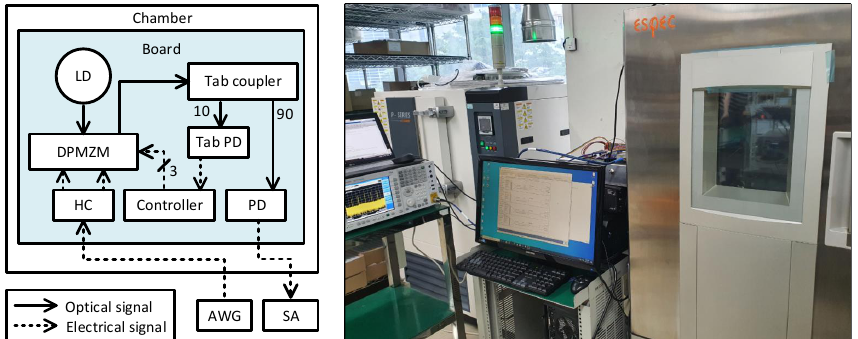
Figure 2. Temperature test set-up for verification of the proposed automatic bias control technique.